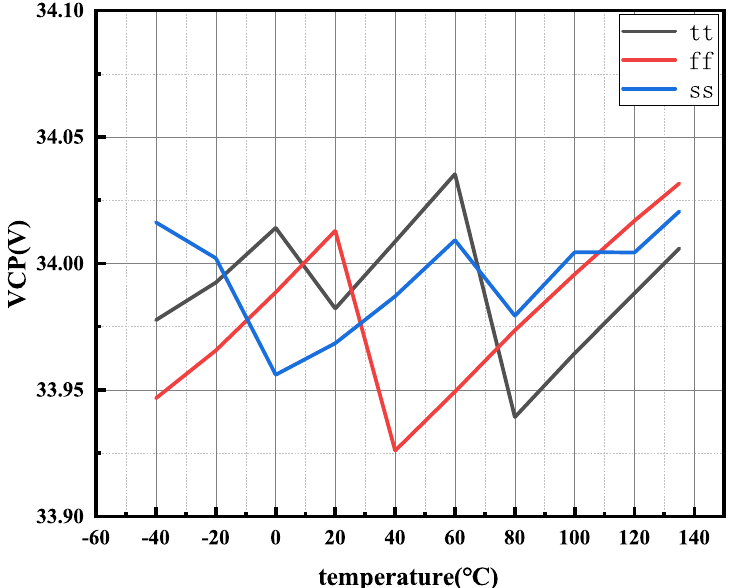
Figure 9. Output voltage VCP when A1A2 = 10, VBB = 24 V.